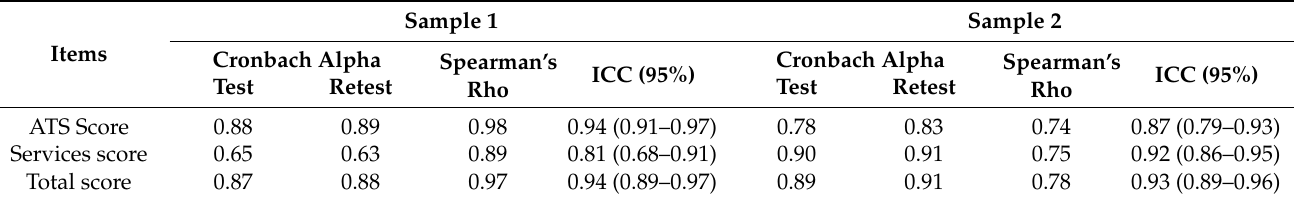
Table 4. Psychometric analysis in sample 1 and sample